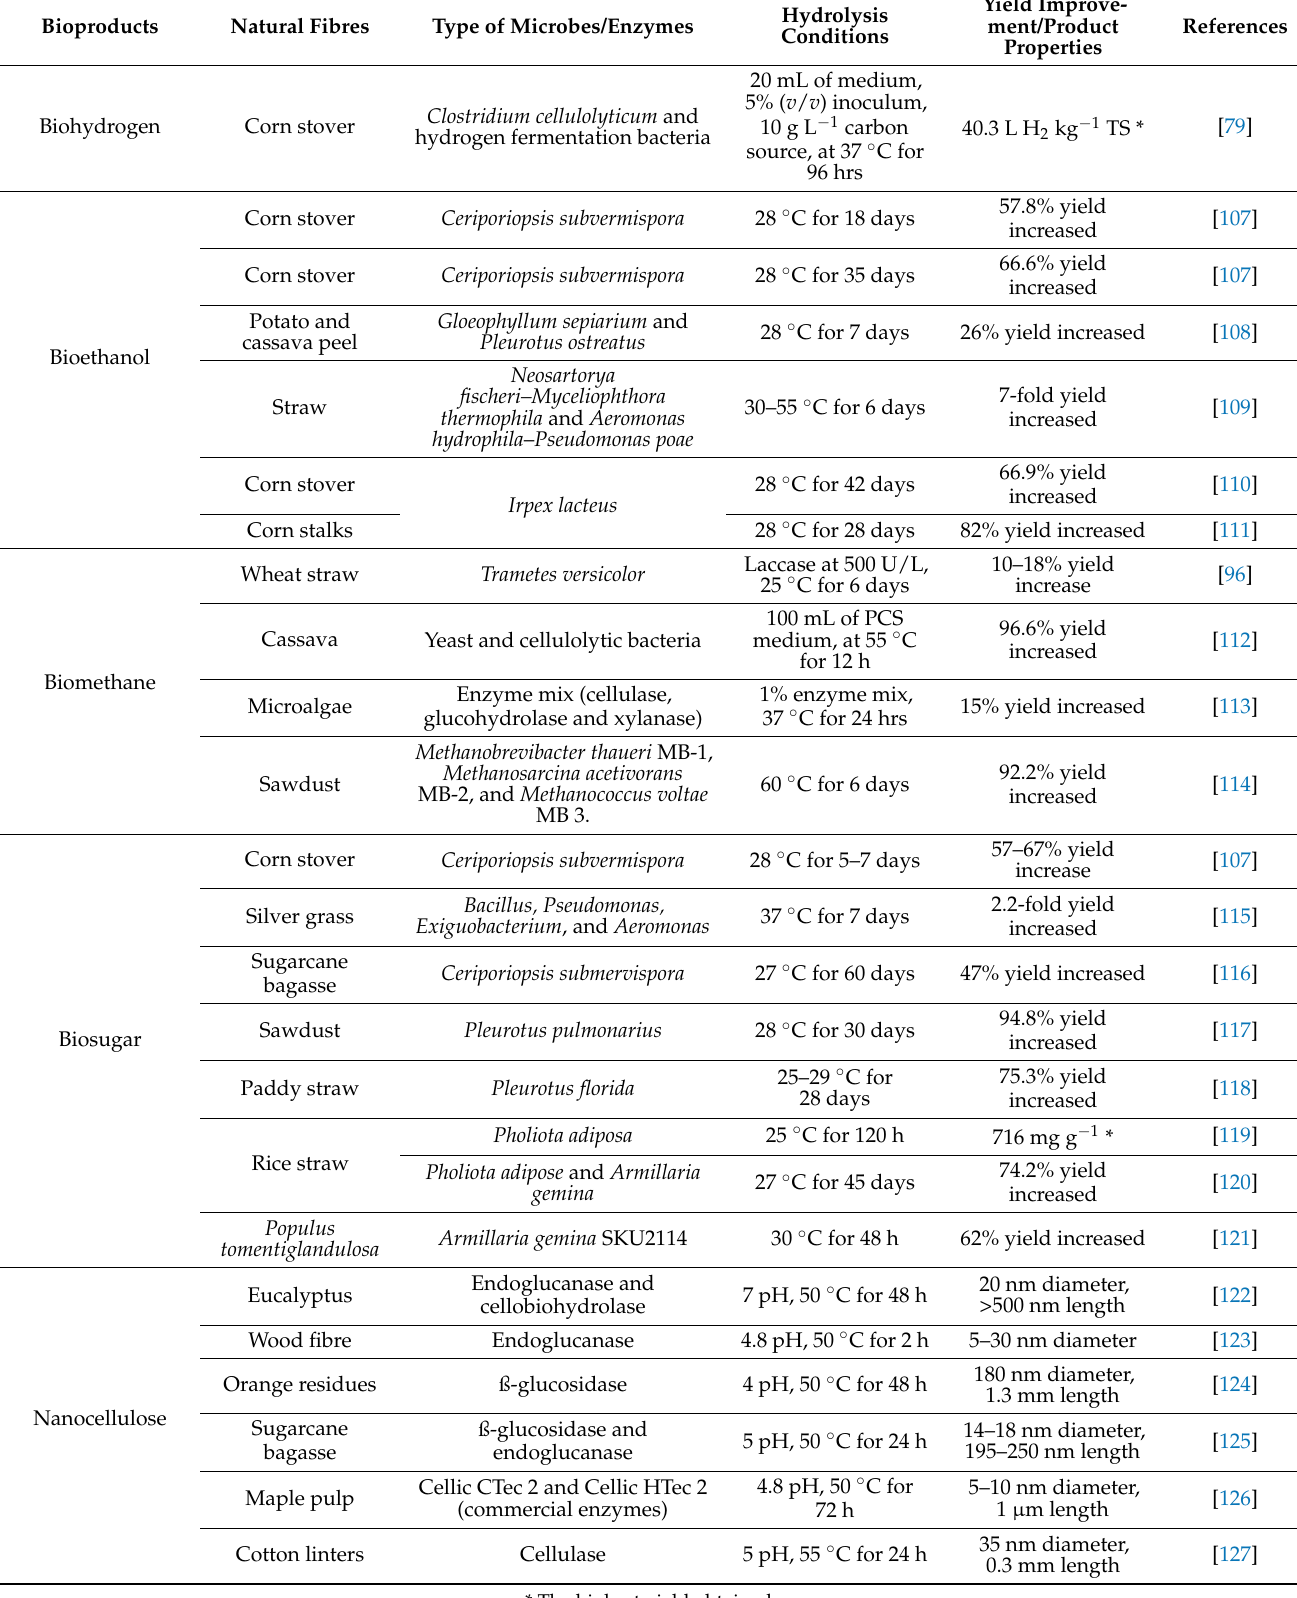
Table 6. A summary of biological pretreatments applied for numerous